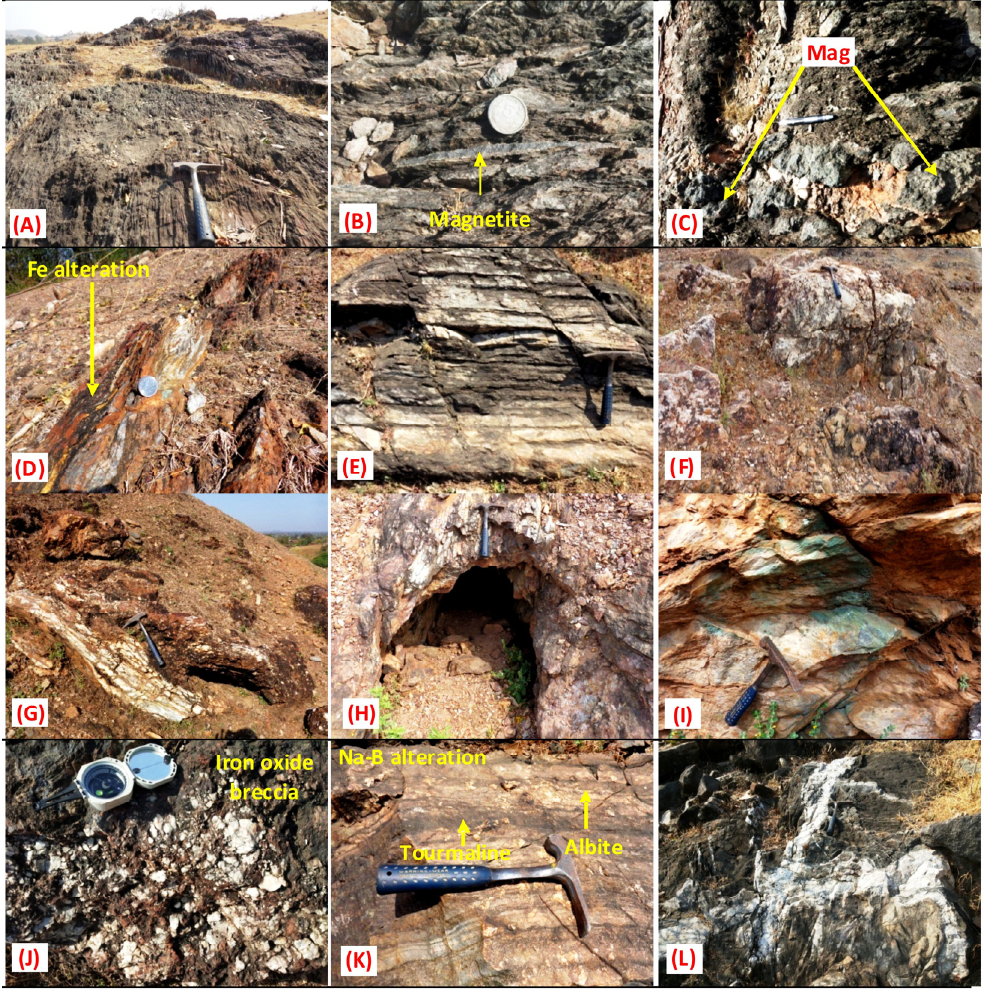
Figure 4. Field photograph showing: ( A ) Well-developed foliation in quartz-mica schist; ( B ) Quartz-mica schist is characterized by the presence of foliation parallel magnetite veins; ( C ) Magnetite veins within quartz-mica schist; ( D ) Intense Fe alteration in quartz-mica schist; ( E ) Albitite occurring within quartz-mica schist as competent bands; ( F ) Ferruginized quartz vein within quartz-mica schist; ( G ) Well developed gossan zone within quartz-mica schist; ( H ) Old workings at contact of quartz-mica schist and albitite; ( I ) Malachite staining in wall of old workings; ( J ) Hydrothermal ferruginized breccias within quartz-mica schist indicate brecciation due to hydrothermal activity; ( K ) Na-B alteration marked by occurrence of albite and tourmaline veins; ( L ) Two generations of quartz veins occurring parallel to S 1 and S 2 foliation, depicting cross cutting relationship with each